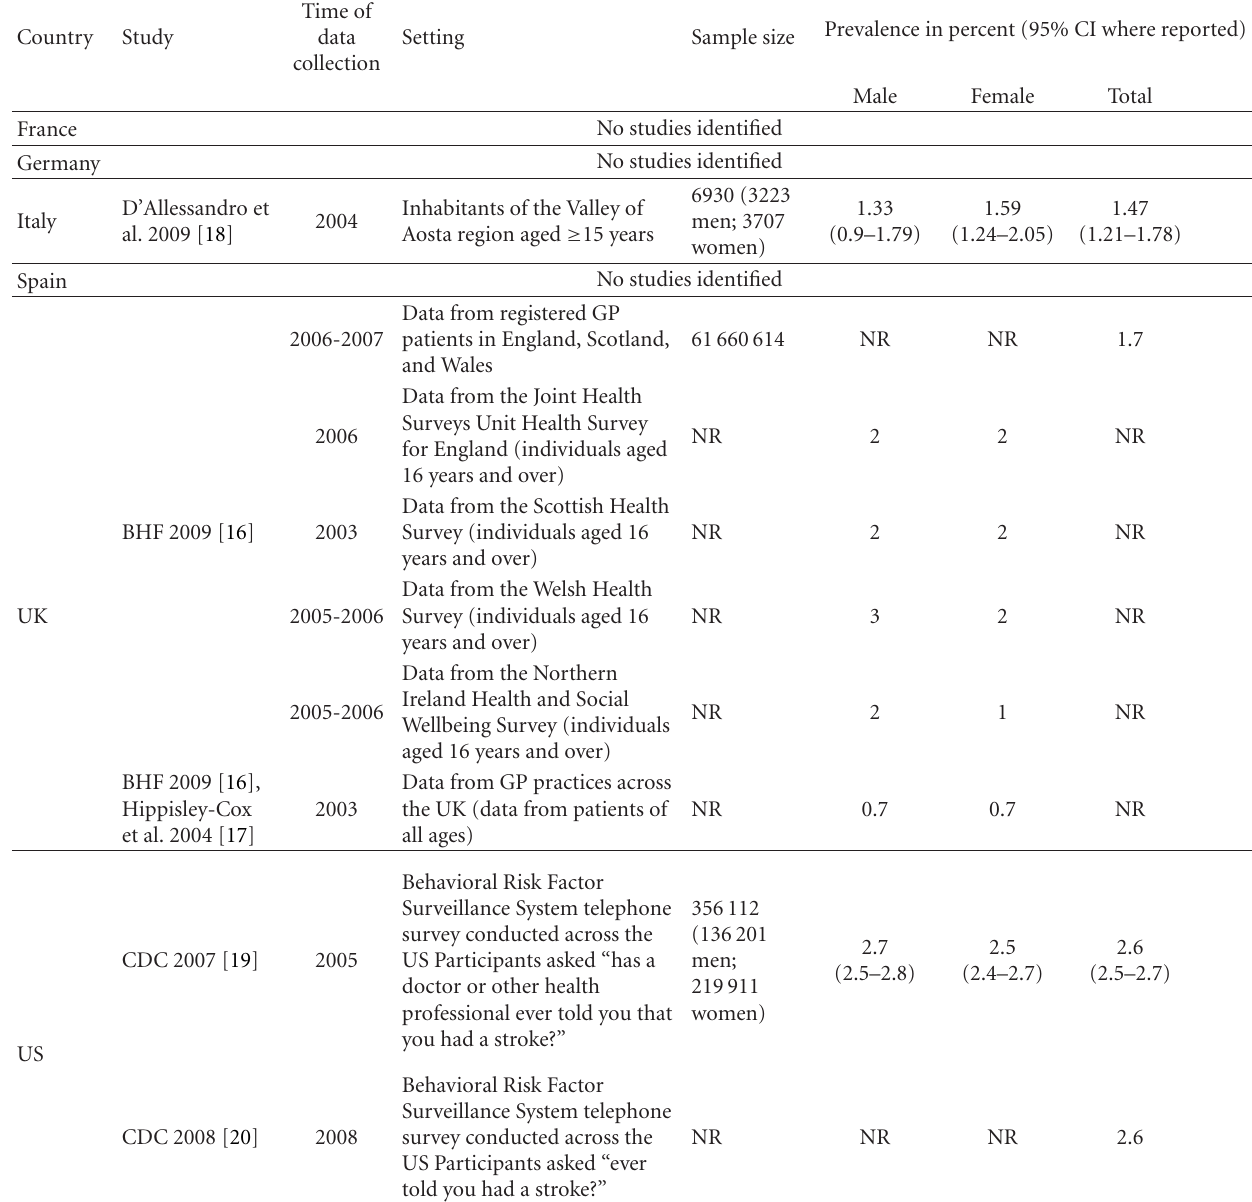
Table 2: Studies reporting prevalence of stroke (any